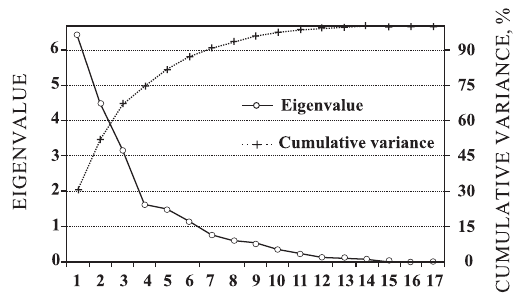
Figure 2. Eigenvalues of all extracted factors and cumulative